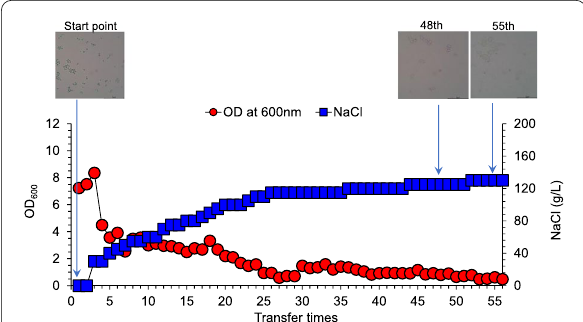
Fig. 1 Adaptive evolution of T. cutaneum ACCC 20271 under varying saline conditions. Synthetic medium supplemented with increasing sodium chloride (from 0 to 130 g/L). The transfer was conducted every 72 h at 30 ℃ into fresh synthetic medium at 10% (v/v) inoculation. Cell morphology was observed with an optical electron microscope ( ×